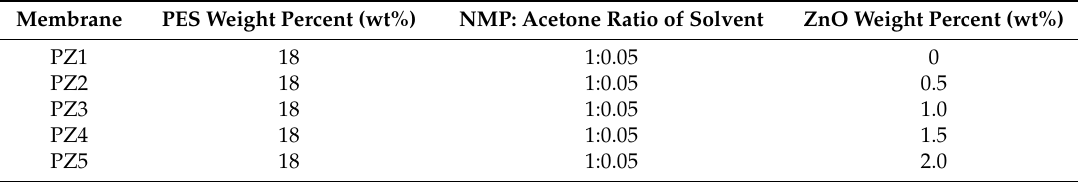
Table 1. The recipe of the cast